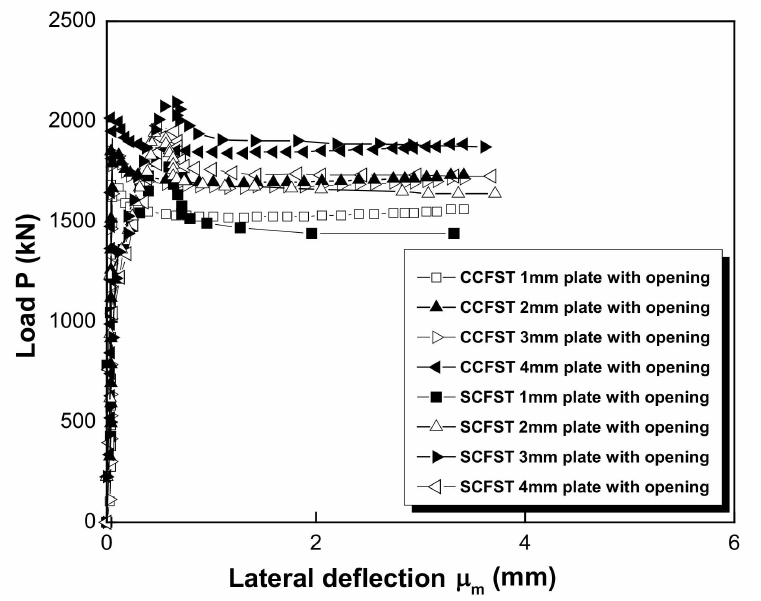
Figure 12. Axial load (P)-lateral deflection (u m ) of CCFST and SCFST models with different cross- shaped plates provided with